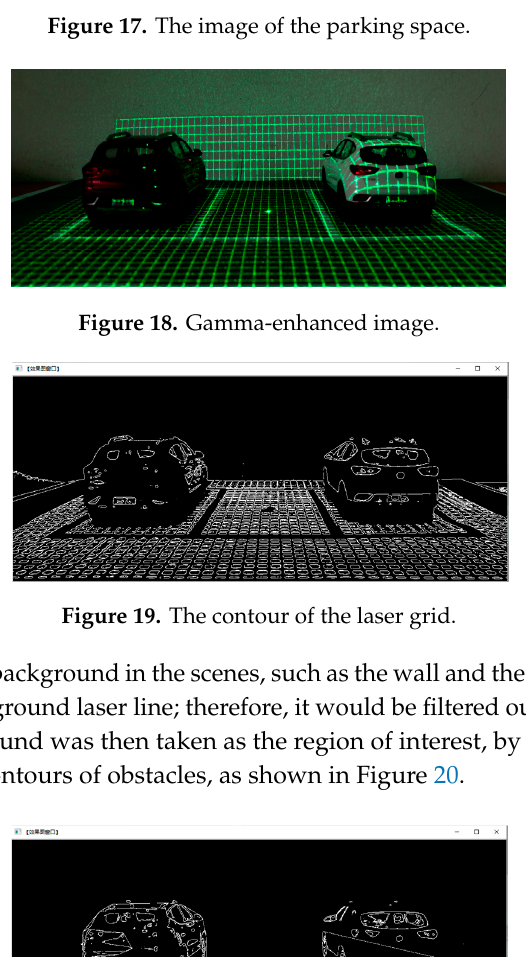
Figure 20. The contour of the cars.